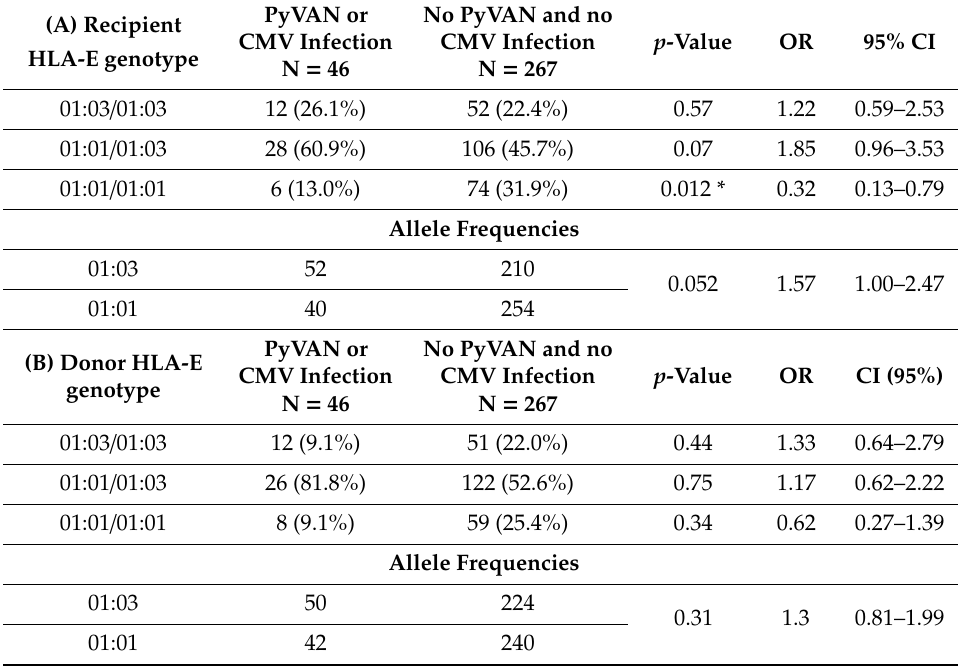
Table 8. Genotype distribution of allele frequencies of HLA-E polymorphism in living-donor kidney transplant recipients (A) and corresponding donors (B) with respect to BK polyomavirus nephropathy (PyVAN) or cytomegalovirus (CMV)